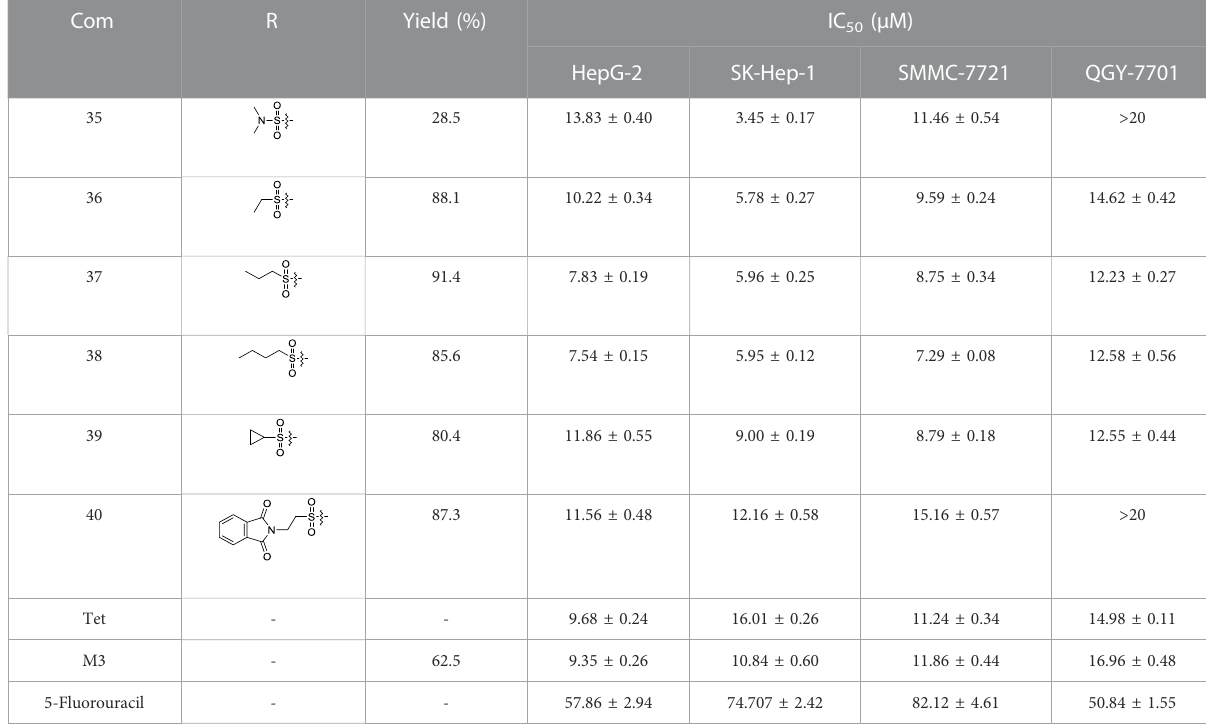
HCC cell lines, namely HepG-2, Sk-Hep-1 SMMC-7721, and QGY-7701 cell lines. 5-Fluorouracil and tetrandrine were used